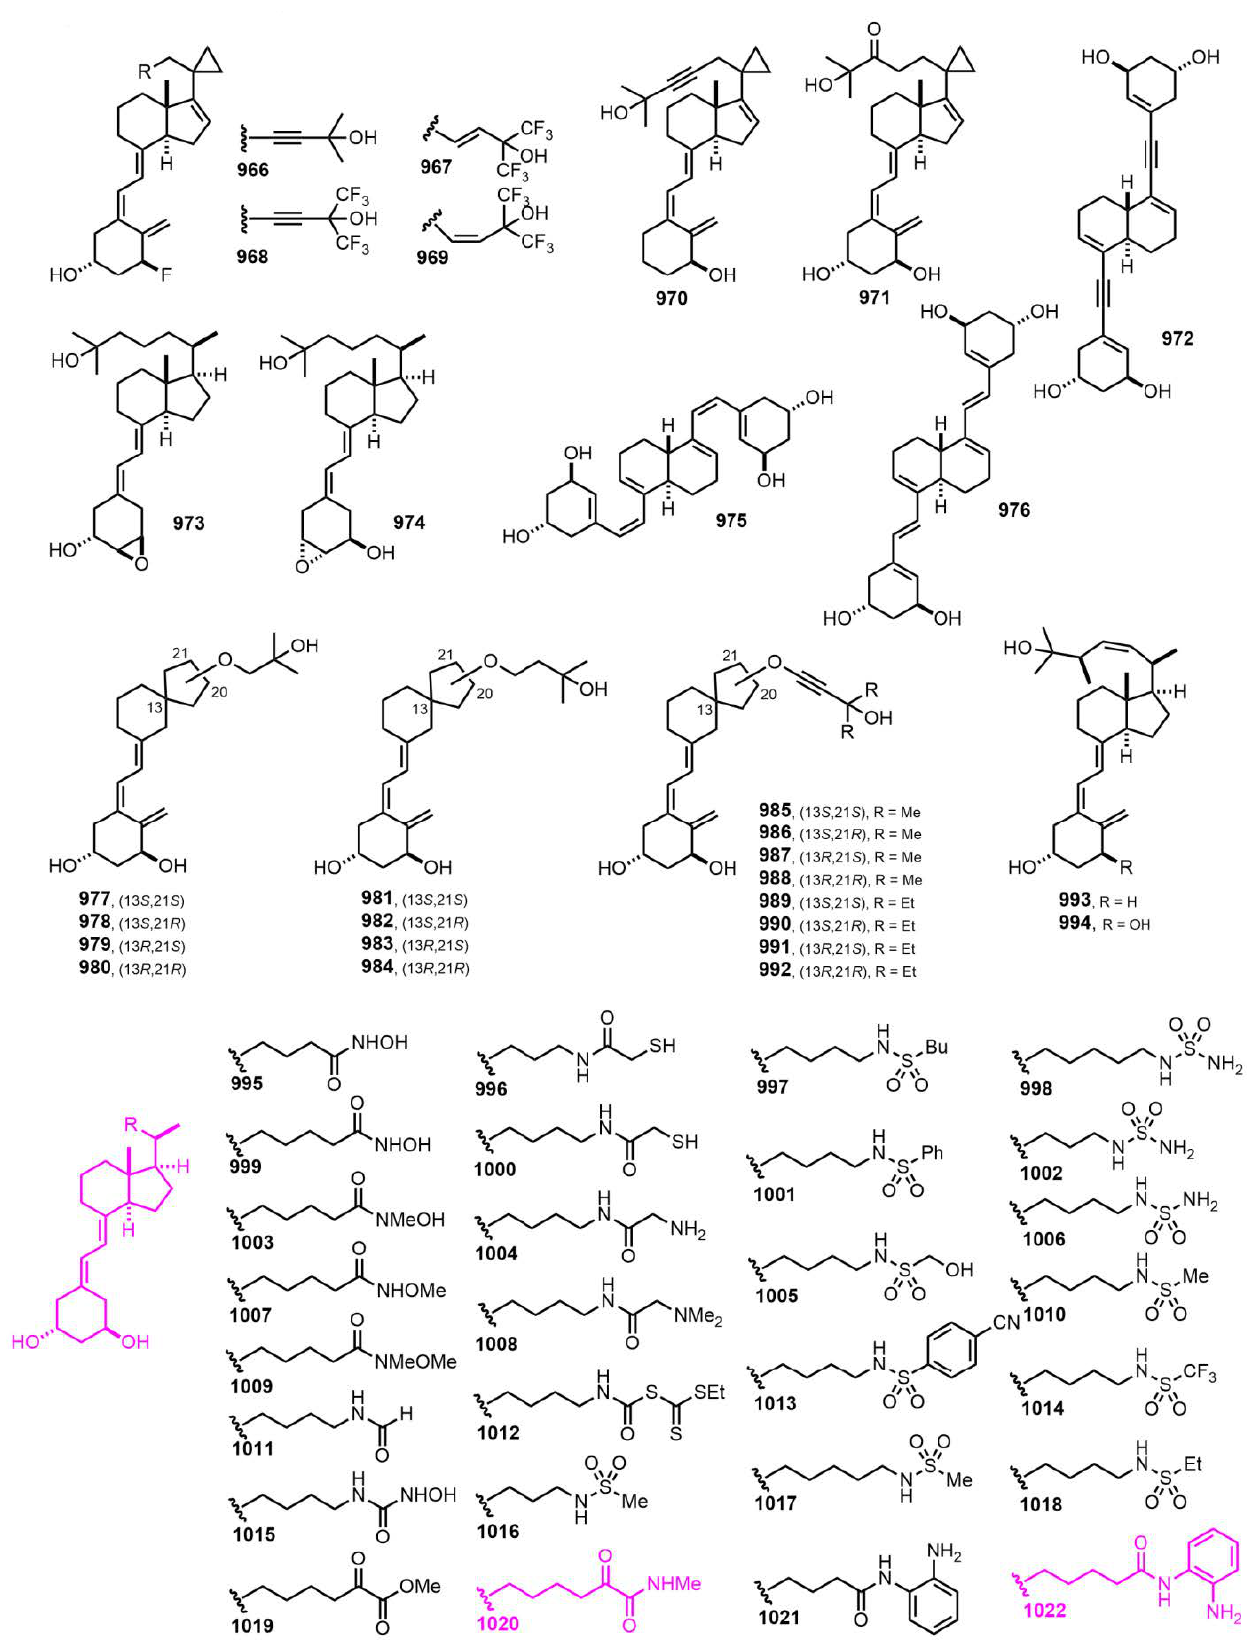
Figure 18. (2009-2010) [265 – 270].